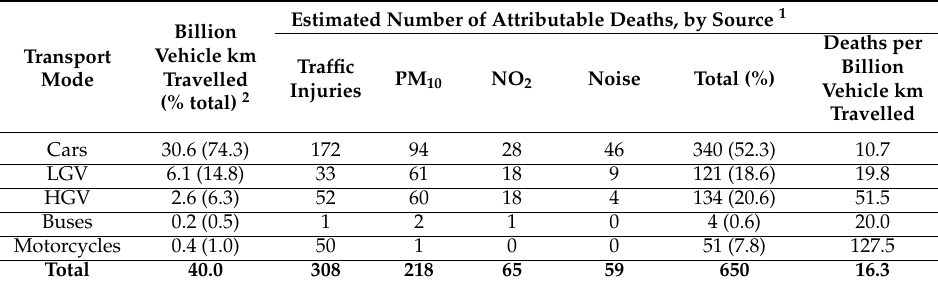
Table 3. Approximate allocation of responsibility for deaths by transport mode,